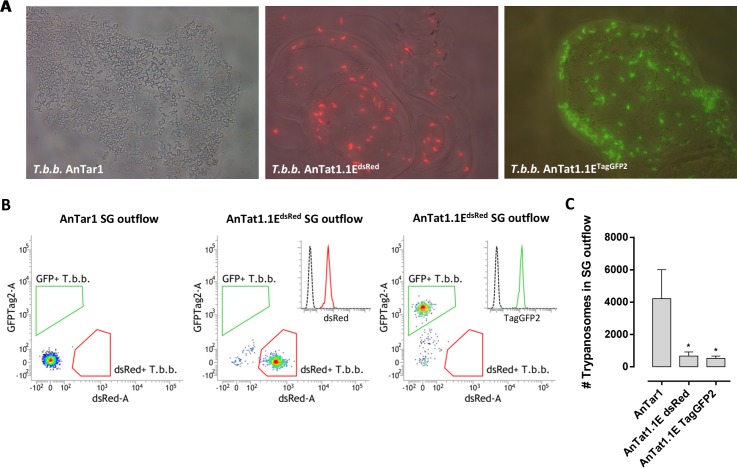
Infection establishment of different T.b.brucei strains in G.m.morsitans tsetse flies.(A) Tsetse saliva deposits containing metacyclic trypanosomes of the T.b.brucei AnTAR1, AnTat1.1EdsRed or AnTat1.1ETagGFP2 strains. Microphotographs are merged brightfield and fluorescence images of saliva deposited on pre-warmed glass slides by SG+ flies infected with the respective parasite strains. (B) Flow cytometric analysis of salivary gland outflows containing AnTAR1, AnTat1.1EdsRed or AnTat1.1ETagGFP2 metacyclic trypanosomes. Fluorescent populations are indicated in the appropriate gates. Histogram insets illustrate the dsRed and TagGFP2 fluorescence in the AnTat1.1E transgenic metacyclics in comparison with the non-tagged AnTAR1 population (dotted line). (C) Trypanosome numbers in the outflows of non-disrupted salivary gland pairs from individual flies (n = 5 /group) infected with one of the three different parasite strains. These differences in parasite density in the salivary glands between the wildtype and the reporter strains were also clear by microscopical inspection in eight independent experiments for the comparison T.b.brucei AnTAR1 (total n = 1666 flies) vs. AnTat1.1EdsRed (n = 2091) and two independent experiments for the comparison T.b.brucei AnTAR1 (n = 245) vs. AnTat1.1ETagGFP2 (n = 228). Parasite numbers in the salivary glands were analysed by flow cytometry. * P < 0.05